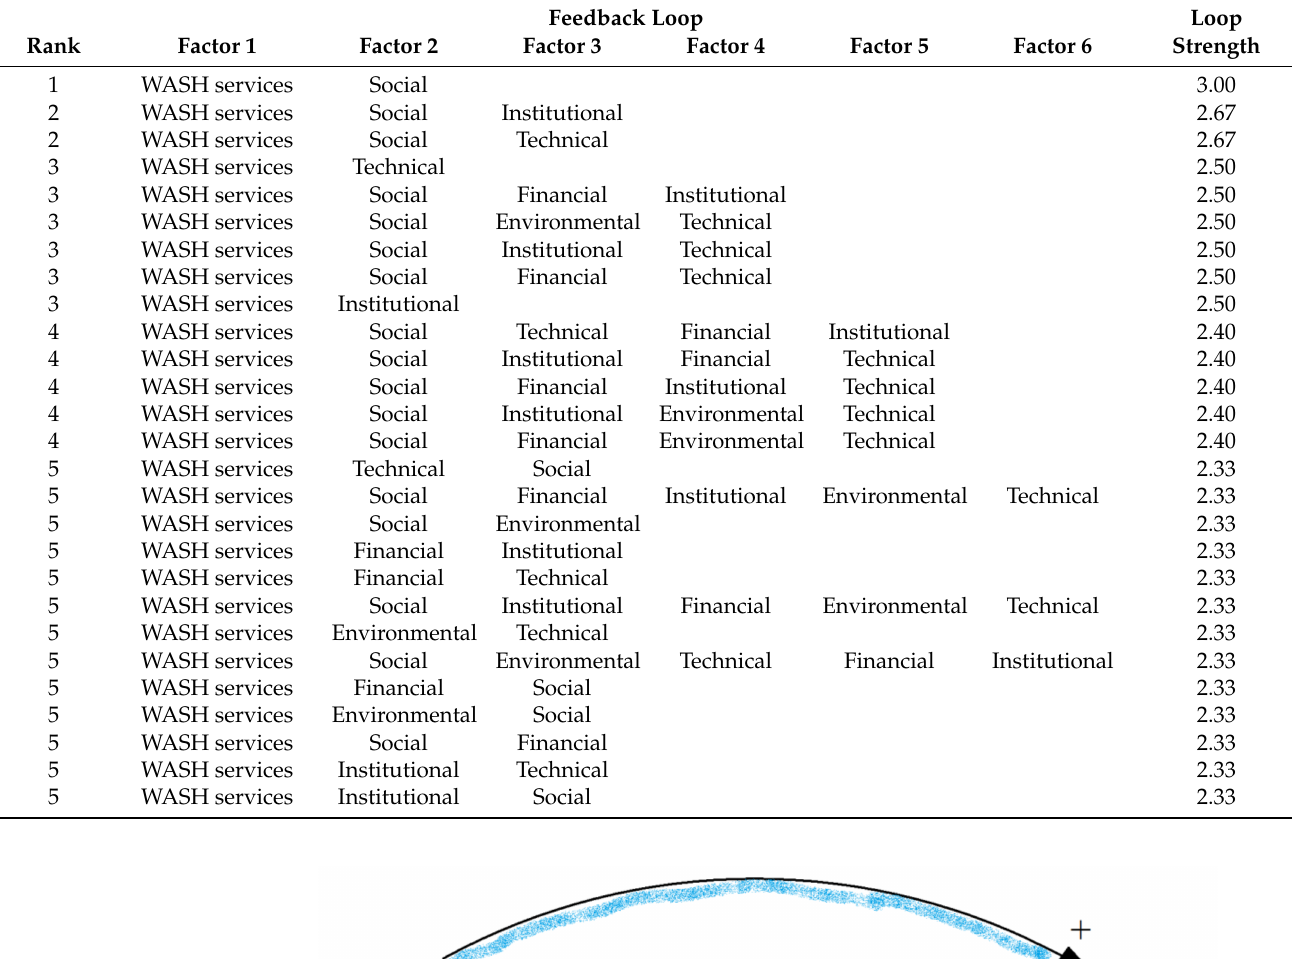
Table 2. Sorted feedback loop based on loop strength. Variable 1–6 columns field shows the factors present within the loop.